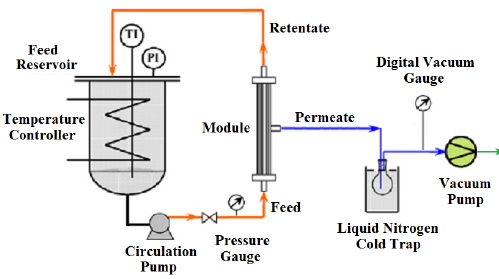
Fig. 2. Schematic drawing of the pervaporation unit.